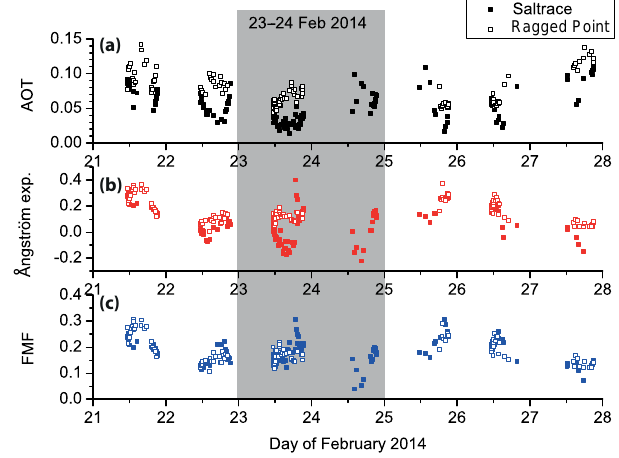
Figure 8. AERONET retrieval products for 21–28 February 2014: (a) Aerosol optical thickness (AOT) at 500nm; (b) Ångström expo- nent (440–870nm); (c) fine mode fraction (FMF). AERONET level 2.0 data from Ragged Point and Barbados_SALTRACE are shown. The gray area highlights the time period of lidar observations dis- cussed in this